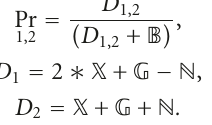
ters: maximum row height h max and number of frames on